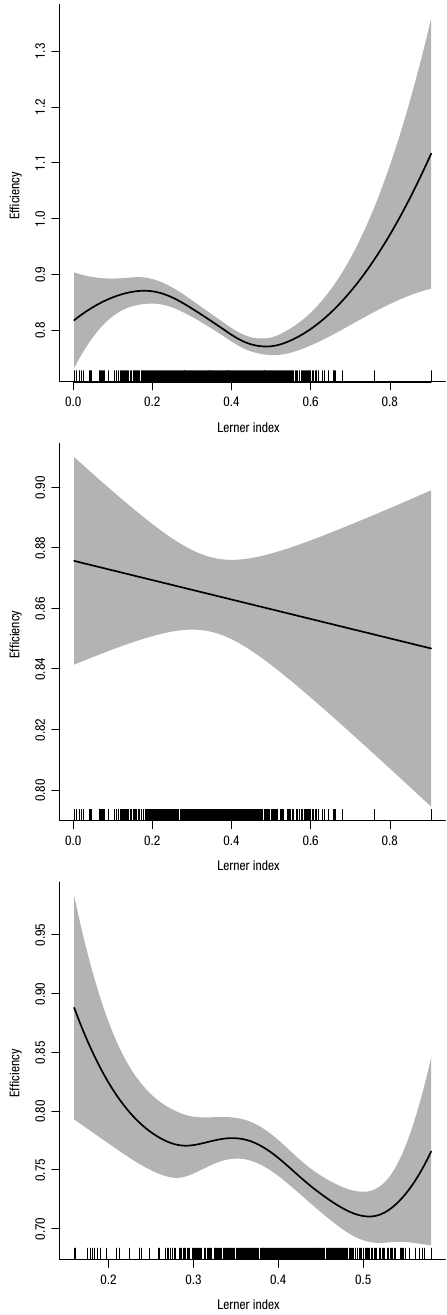
Fig. 7. Allocative efficiency vs. market power (Lerner index), spline smoothing regression,